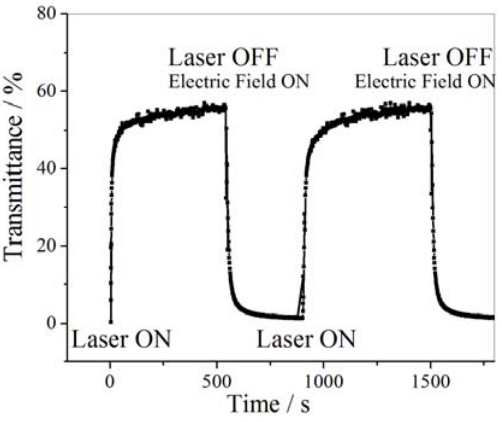
Figure 31. Transmittance behavior on a cyclic red light and electric pulse.